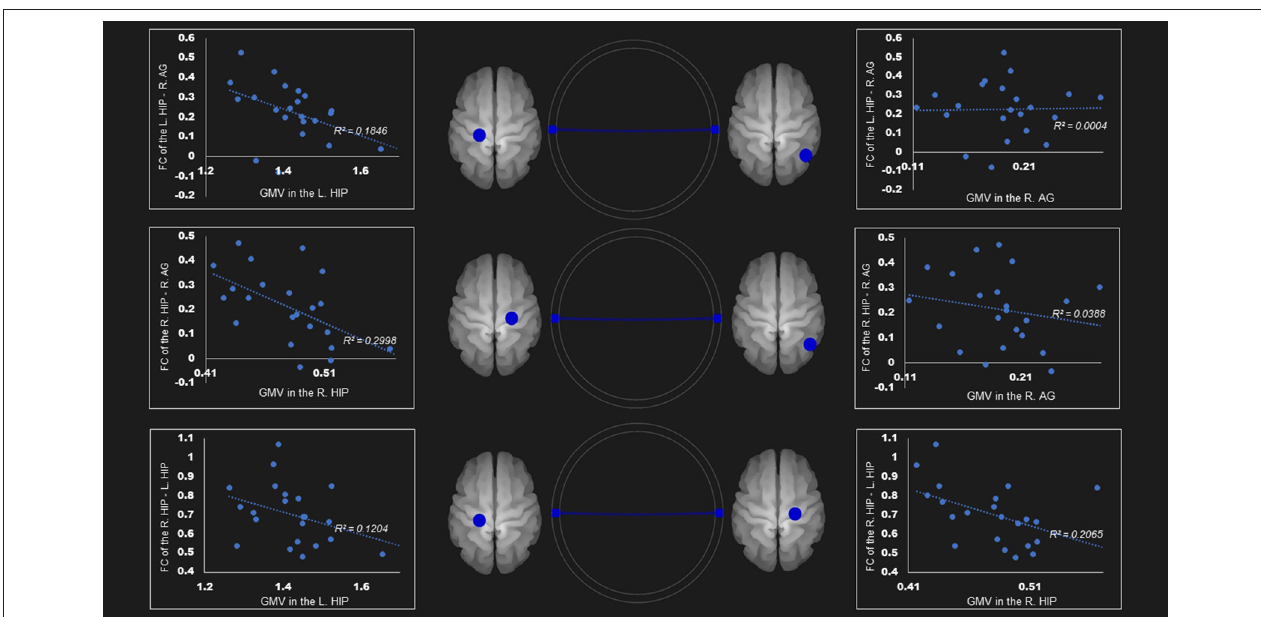
FIGURE 2 | Correlation between FC and gray matter volume in the dorsal default mode network in the AUD group. Gray matter volume of right hippocampus was negatively associated with the FC of (1) the right hippocampus—right angular gyrus ( r = − 0.55); (2) the right hippocampus—the left hippocampus ( r = − 0.45). Left hippocampus volume was also negatively linked to the FC of (1) the left hippocampus—right angular gyrus ( r = − 0.43); (2) the right hippocampus—the left hippocampus ( r = − 0.35). Blue lines represent the negative functional connectivity between ROIs, respectively. FC, functional connection; AG, angular gyrus; AUD, alcohol use disorder group; Hip, hippocampus; L, left; R, right.